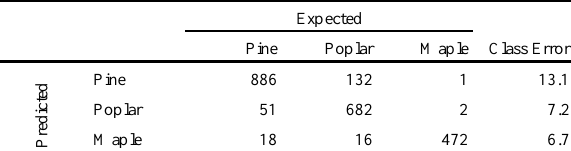
Table 4. Confusion matrix for the classification accuracy averaged over 20 iterations using 30% of the data for training using vertical profile derived features (values are average over 20 iterations) We used 70% of the 160 trees for validation; when this process is repeated 20 times with different samples, this result in 2240 trees. The overall accuracy for both methods is 90% and both methods exhibit lowest class error when classifying maple